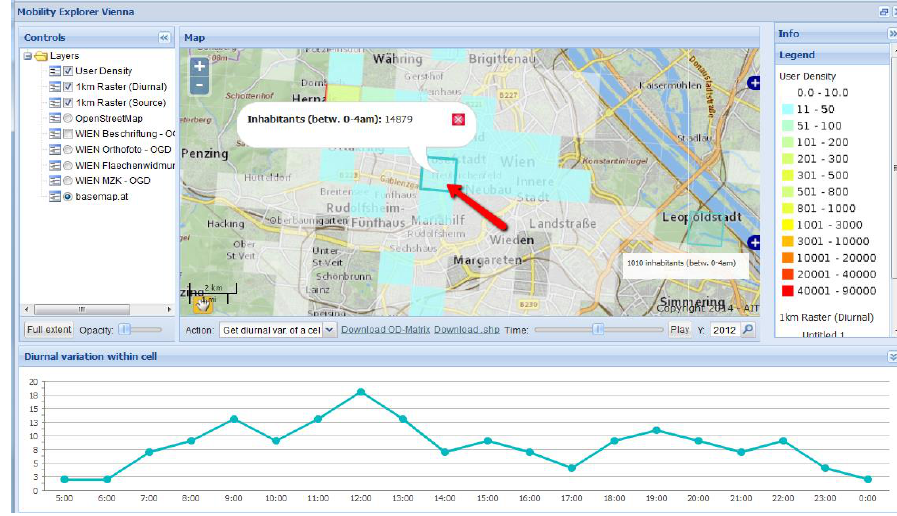
Figure 9. Map accompanied by a line chart of the diurnal cell occupancy of visitors of an interactively selected target cell in Vienna (cyan outline) from selected source cell (red outline).